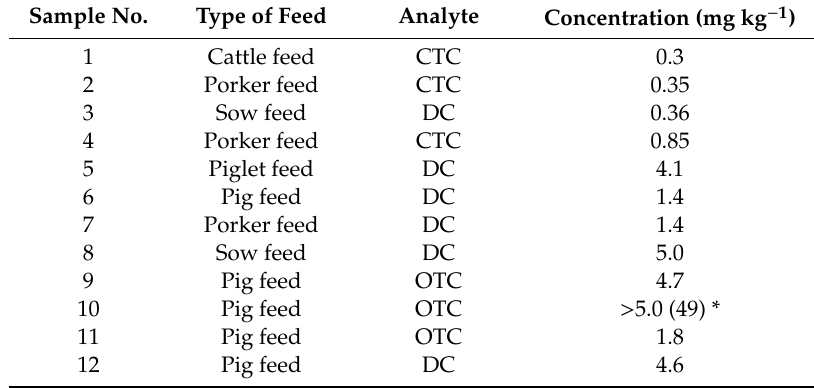
Table 2. The analytes and their concentrations detected in samples with an indication of the type of